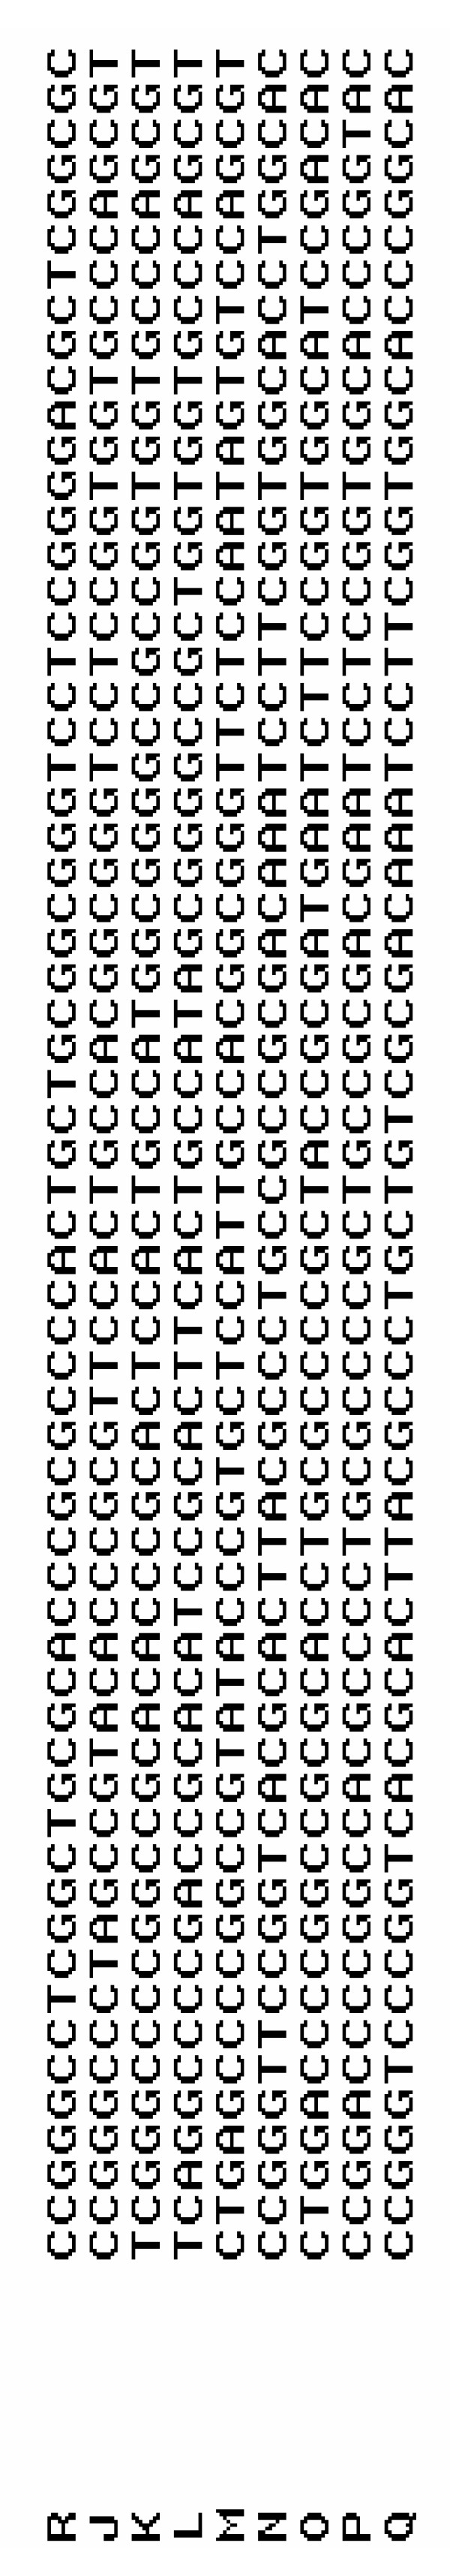
Input sequence set in a form of alignment. Alignment of 9 sequences representing phage T7 isolates described in the study of experimental phylogeny of Hillis et al. [6]. Sequences comprise 63 informative sites of a 1091 bp segment of phage T7 genome as presented in Table 1 of Li et al. [5].